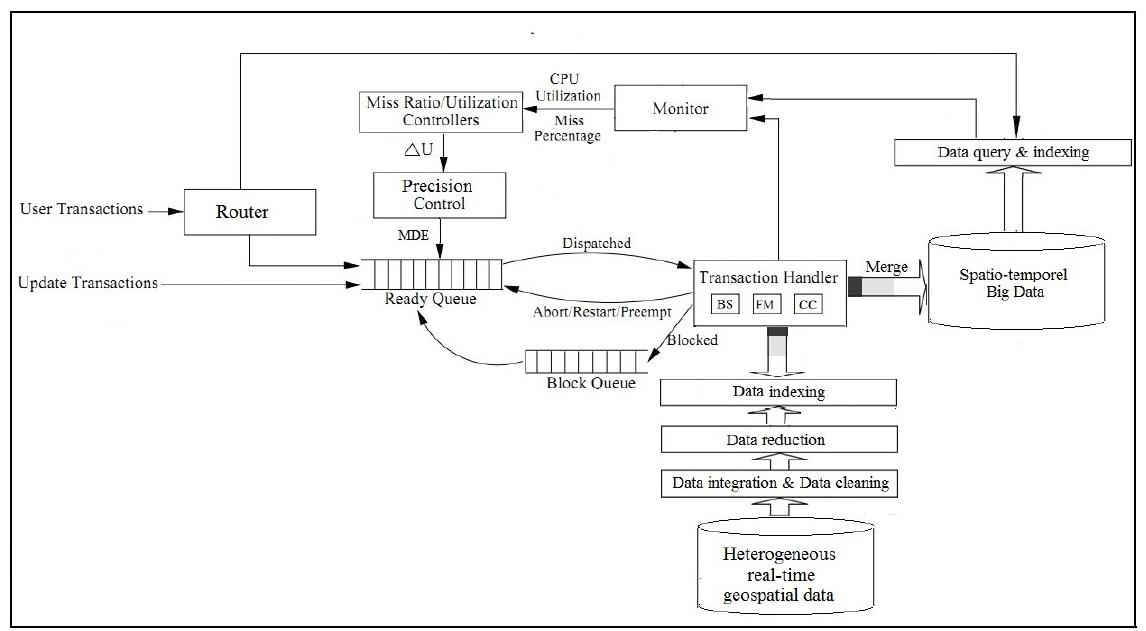
Figure 1: A Feedback Control Scheduling Architecture for Real-Time Spatial Big Data: